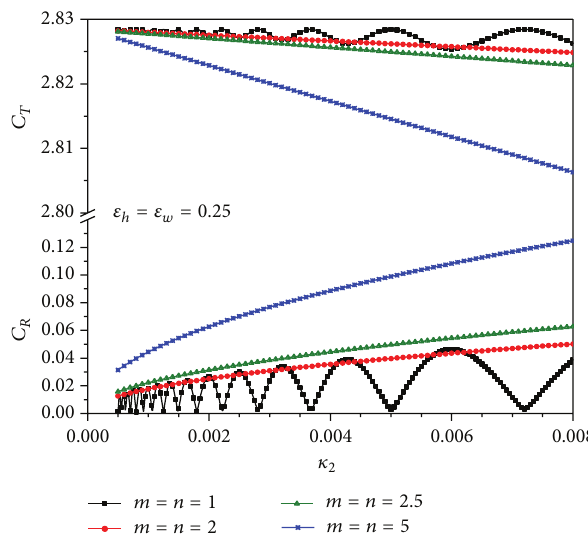
Figure 6: Reflection/transmission coefficients as a function of the kinematical parameter 𝜅 2 with 𝜀 𝑤 = 1 and 𝜀 ℎ = 0 . 25 for four values of 𝑛(= 1 , 2 , 2 . 5 , 5 ) .